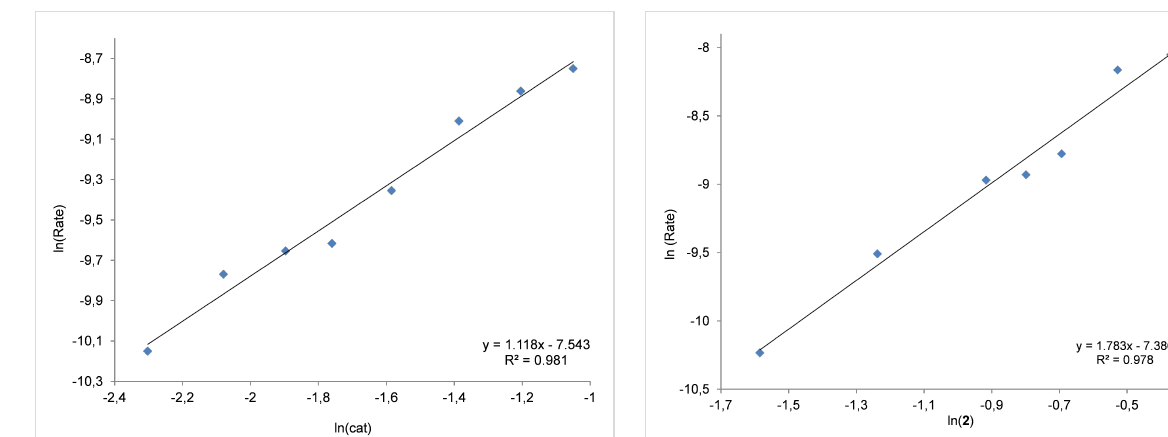
functions in the ligand scaffold [46]. The presence of reminis- cent Zn–I coordination patterns has also been reported by our group [47]. Another possible barrier to overcome is the (strong) ion-pair effect between the methylpyridinium unit in 2 and the iodide when comparing to the binary system Zn(salphen) 1 /NBu 4 I. Thus, to potentially break the Zn–I coordinative inter- action and to enable both Lewis acid and nucleophilic functions, the reaction had to be heated to at least to 40 °C. A similar